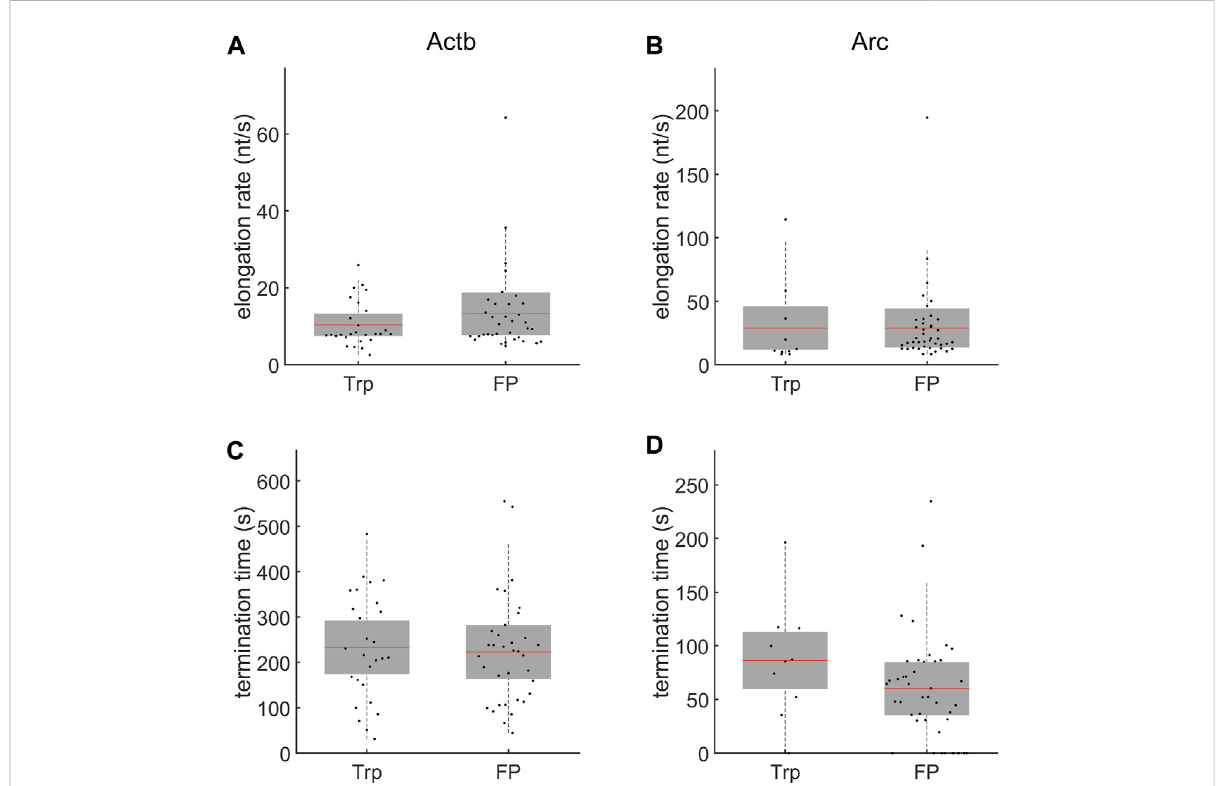
FIGURE 4 Comparison oftime-resolvedmeasurements after addingtriptolide(Trp)and fl avopiridol (FP). (A,B) The elongation ratesofActb (A) andArc (B) . TheelongationratesmeasuredafteraddingTrpandFPweresimilarforeachgene. (C,D) TheterminationtimesofActb (C) andArc (D) .Themean(red line) and standard deviation (SD, gray box) values are indicated. No signi fi cant difference was observed between experiments using Trp (n = 27 transcription sites for Actb and 10 for Arc) and FP (n = 35 transcription sites for Actb and 42 for Arc) ( P > 0 . 05, Wilcoxon rank-sum